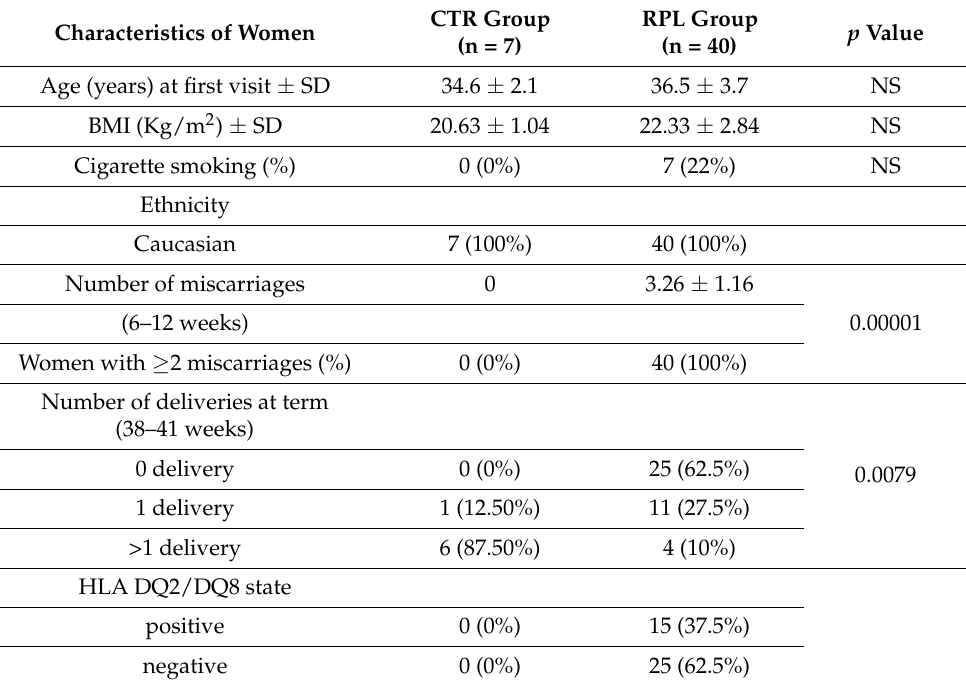
Table 1. Characteristics of women included in the study. Results are expressed in average ± standard deviation (SD) or percentage (%) of the total, where deemed appropriate. CTR control women; RPL recurrent pregnancy loss; n: number, BMI body mass index, NS not significant, N/A not